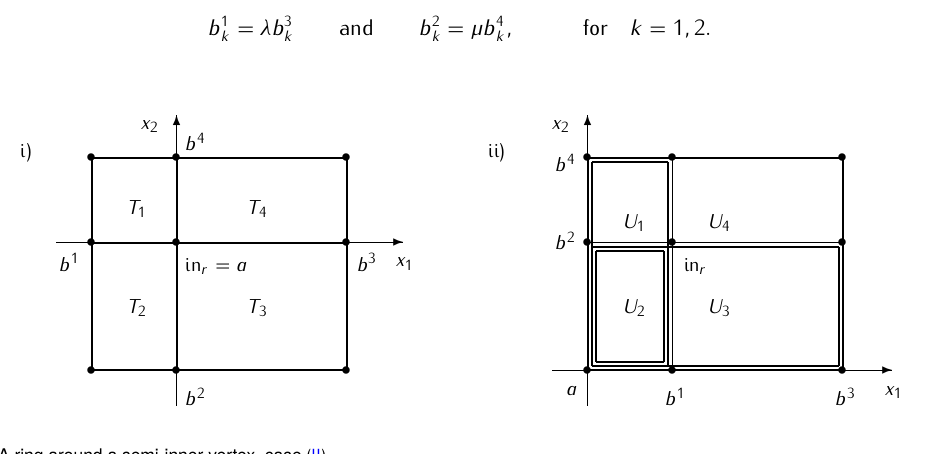
Figure 4. A ring around a semi-inner vertex, case